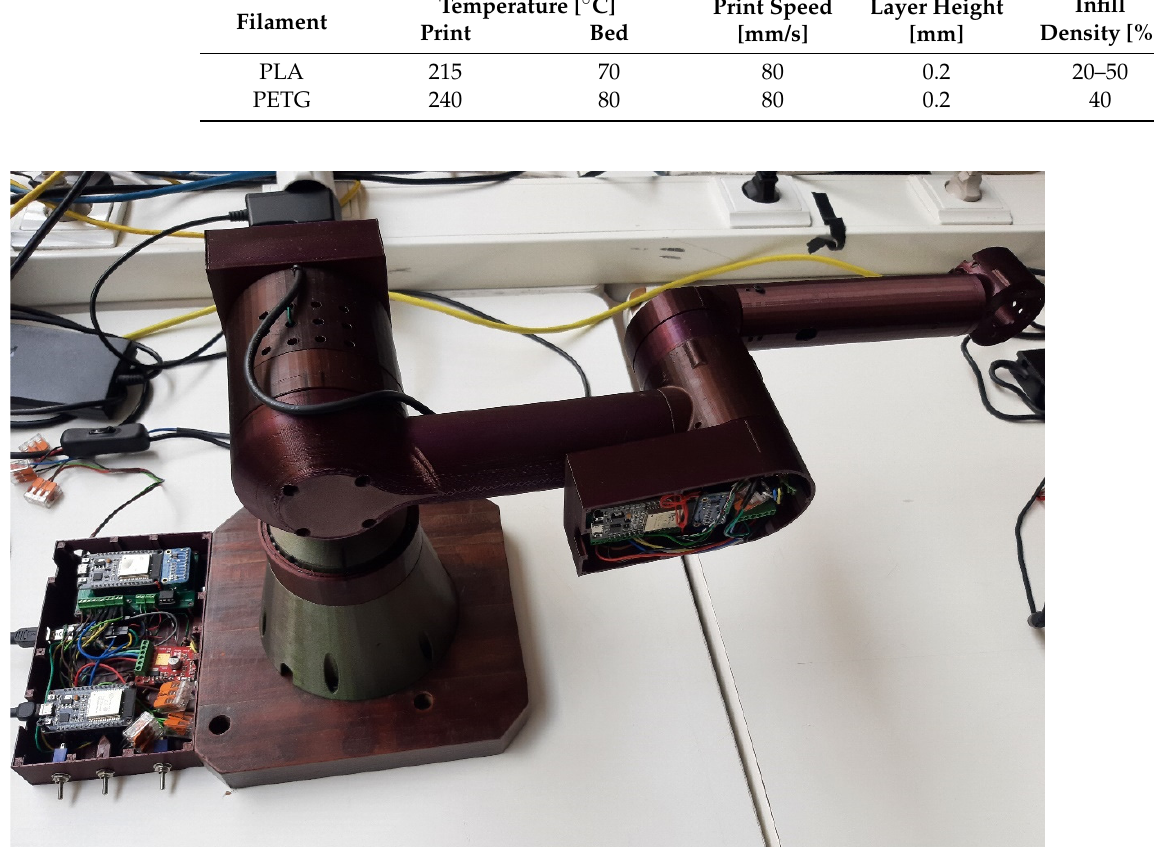
Figure 15. Final assembled robotic